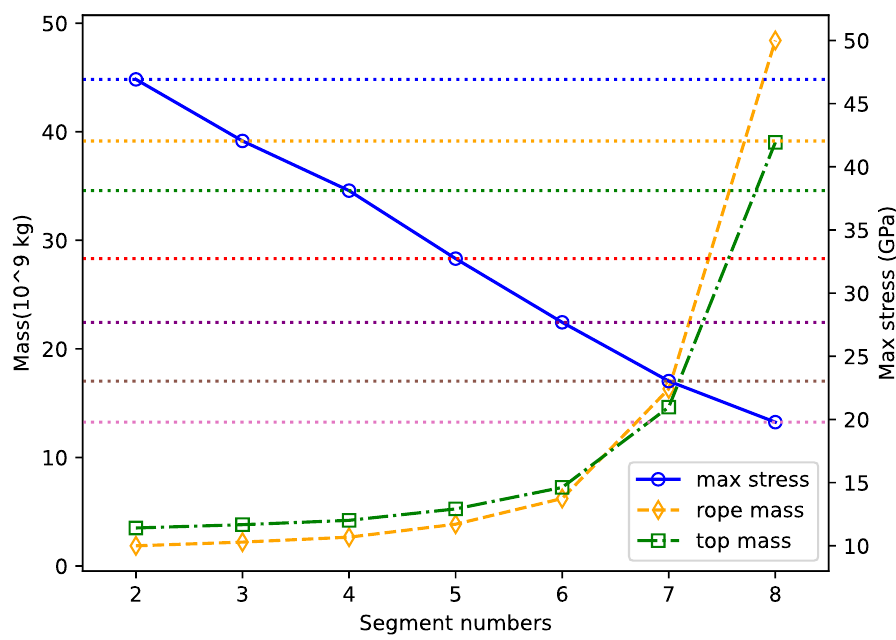
Figure 12. Maximum stress and mass curve of segmented space elevator system with 2 to 8